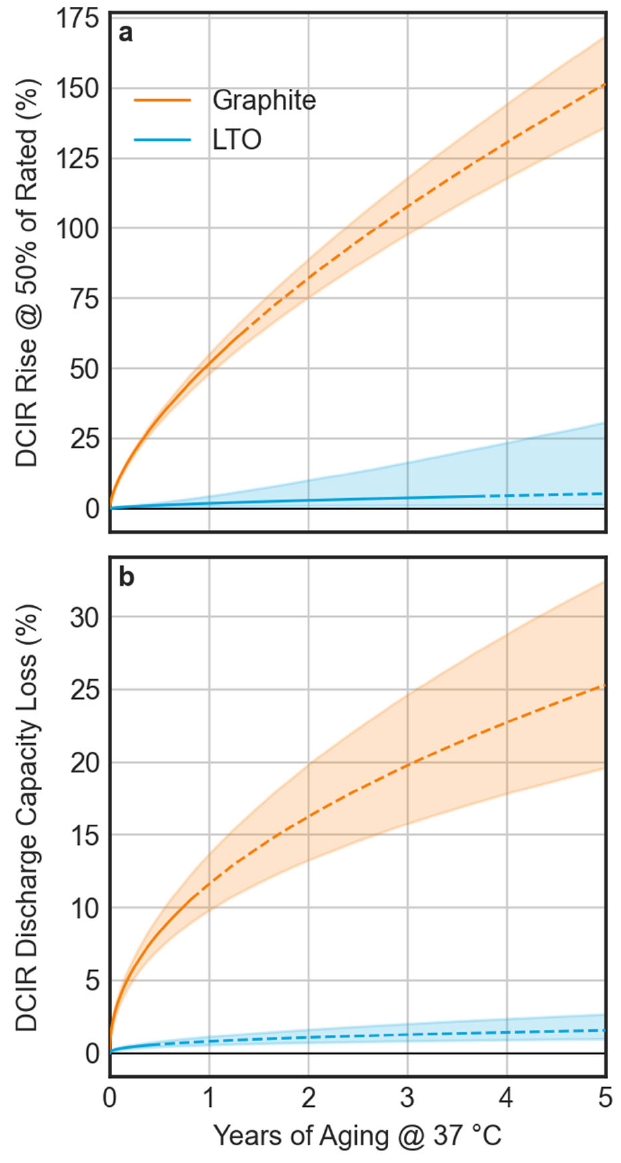
Figure 14. Long-term aging prediction at 37 ◦ C. Solid lines represent the prediction within the range of aging observed in the accelerated aging test. Dotted lines reflect the extrapolated performance beyond this point. Shaded regions reflect the 95% confidence interval for the population mean. ( a ) The predicted rise in DCIR @ 50% SOC; ( b ) the predicted DCIR discharge capacity loss.